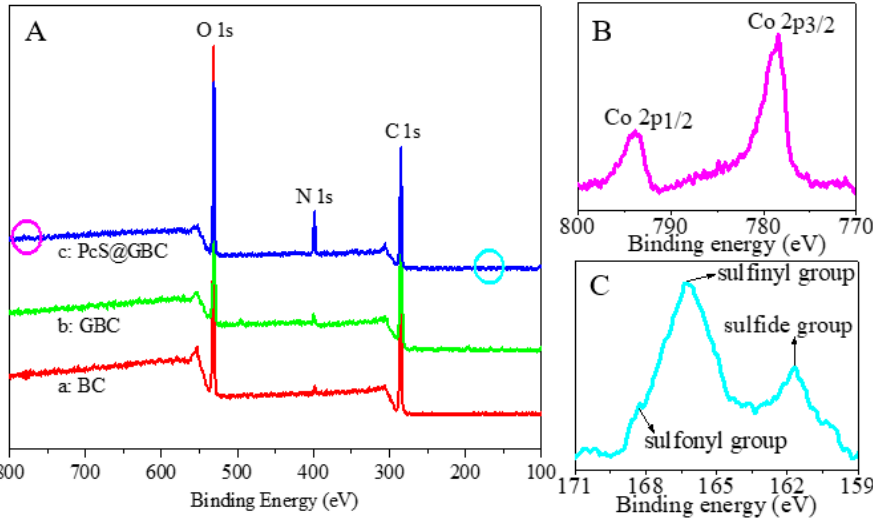
Figure 2. ( A ) XPS spectra of a: BC, b: GBC, and c: PcS@GBC; the details of the Co region ( B ) and S region ( C ) of PcS@GBC. region ( C ) of